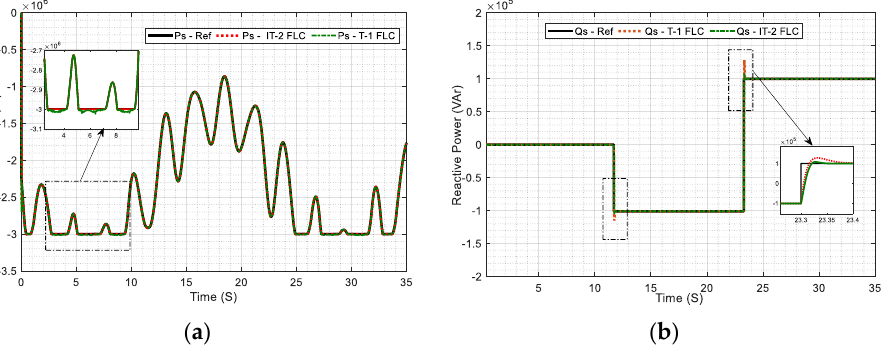
Figure 14. ( a ) Active power tracking comparison under parameters variation; ( b ) reactive power tracking comparison under parameters variation.